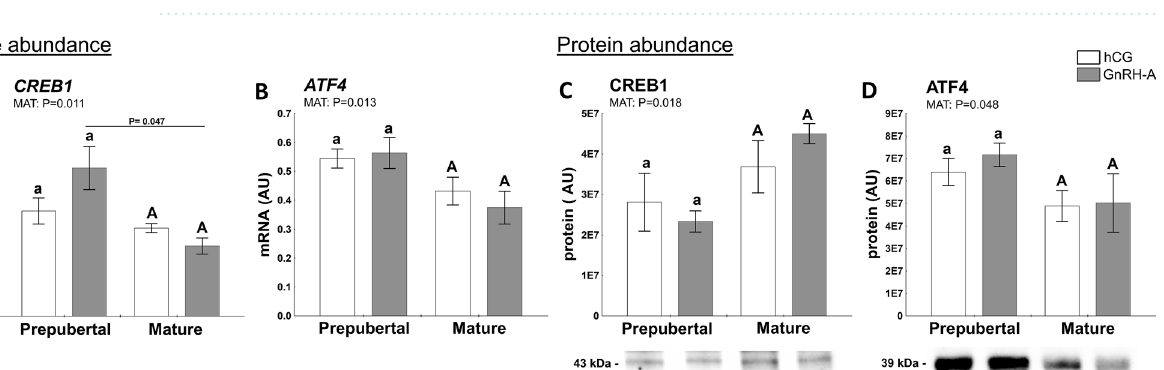
Figure 4. Hormones (hCG and GnRH-A; HORMONE) and sexual maturity status (prepuberty or maturity; MAT) affect abundance of extracellular matrix regulators in ovarian follicles of prepubertal and mature gilts. The abundance of MMP1 ( A , C ) and TIMP1 ( B , D ) in prepubertal and mature gilts was evaluated. Gene expression was normalized to the geometric mean of ACTB and GAPDH (AU), identified as the best reference genes by NormFinder algorithm. Protein levels were normalized to either total protein content (AU) using TGX Stain-Free gel technology ( D ) or GAPDH loading control ( C ). Uncropped blots are presented in Supplementary Fig. 3C online. Data were analyzed using two-way ANOVA with Sidak multiple comparison (mRNA) or Tukey (protein) post-hoc tests and are presented as mean ± SEM (n = 5–6 per group). Means with different superscripts differ significantly (small letters—prepubertal gilts, capital letters—mature gilts; P < 0.05). Line with a P value denote significant differences between prepubertal and mature gilts. AU – arbitrary units.